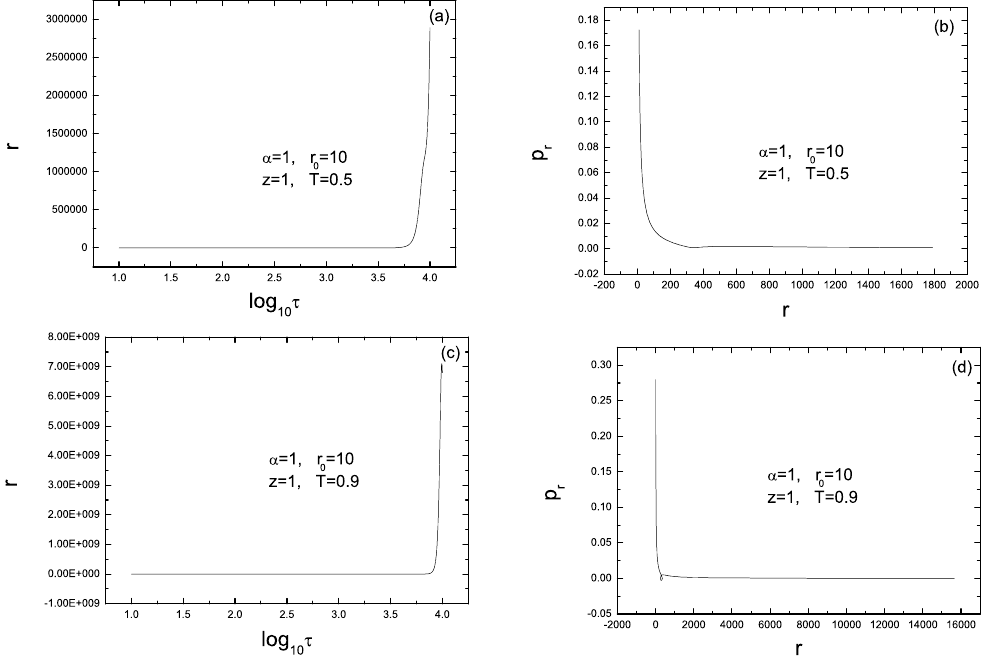
Figure 3 . The time evolution of r ( (cid:28) ) (left panels) and the phase space ( r; p r ) (right panels) with r 0 = 10 for di(cid:11)erent temperatures (the panels above are T = 0 : 5 and that below are T = 0 : 9). Here, we have set (cid:11) = 1, (cid:18) = 0, z = 1, E = 5, (cid:12) = 1 =(cid:25) , (cid:26) = 0 : 01 and p (cid:26) = 0.